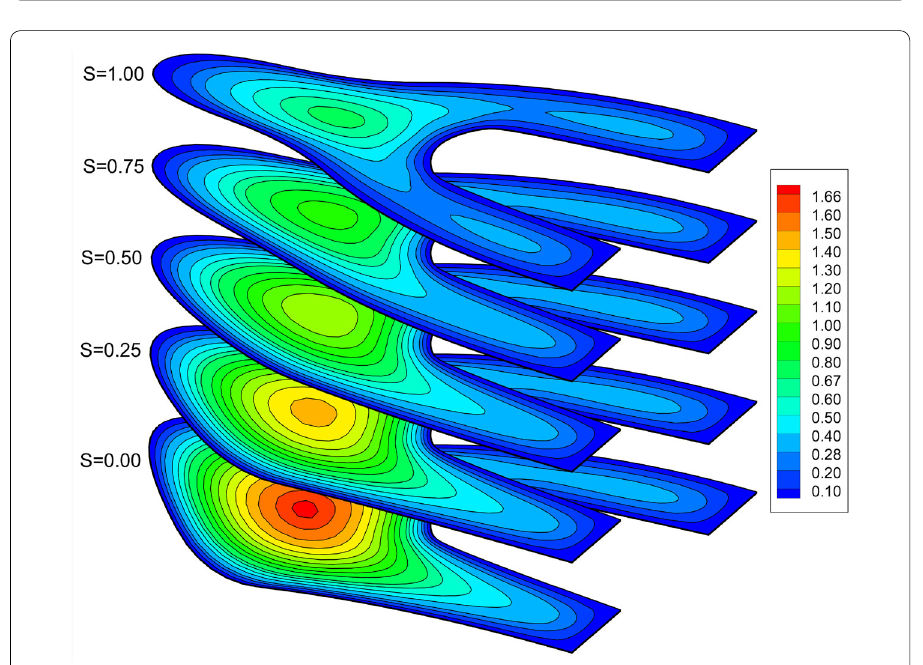
Fig. 24 Solutions in the physical domain related to those shown in Fig.